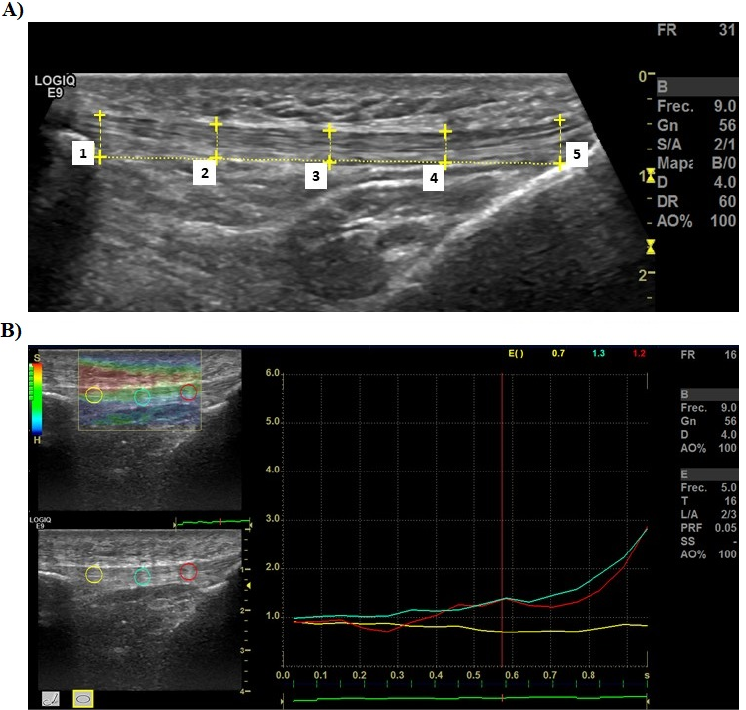
Figure 3. ( A ) B-mode ultrasound image of the Achilles tendon in a longitudinal plane. ( B ) Example of elastography measurement of the Achilles tendon.